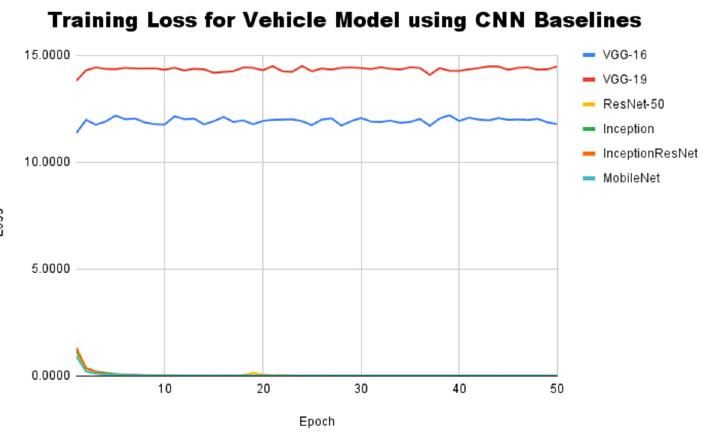
Figure 7. Training loss for vehicle model classification using CNN baseline architectures.